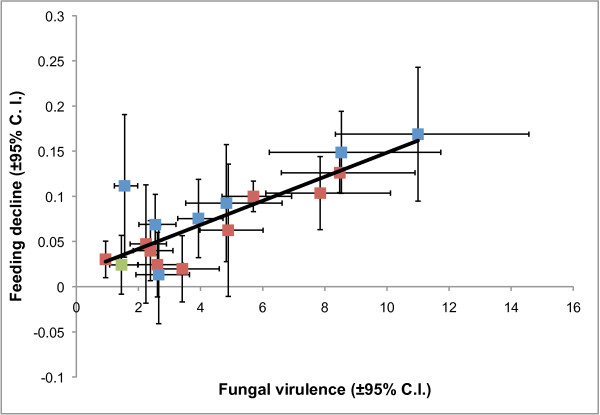
The relationship between fungal virulence (the hazard ratio as in Table2and Figure2A) and the reduction in feeding propensity (Table3and Figure2A). Fitted line shows a linear regression where Reduction in feeding propensity = (Hazard ratio × 0.015)+ 0.013. Blue squares are B. bassiana isolates, red squares Metarhizium isolates and the green square an Isaria farinosus isolate.